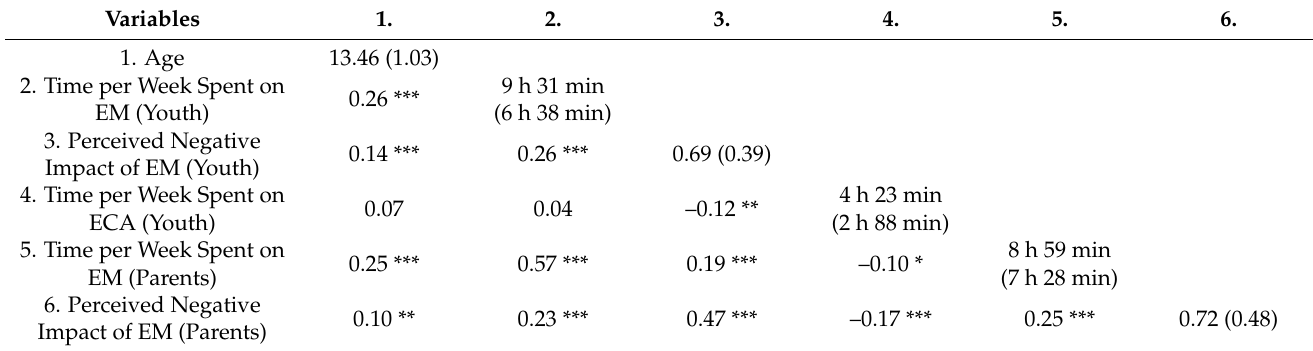
Table 3. Means, standard deviations, and correlations between age, time spent with electronic media (EM), time spent on extracurricular activities (ECAs), and perceived negative impact of